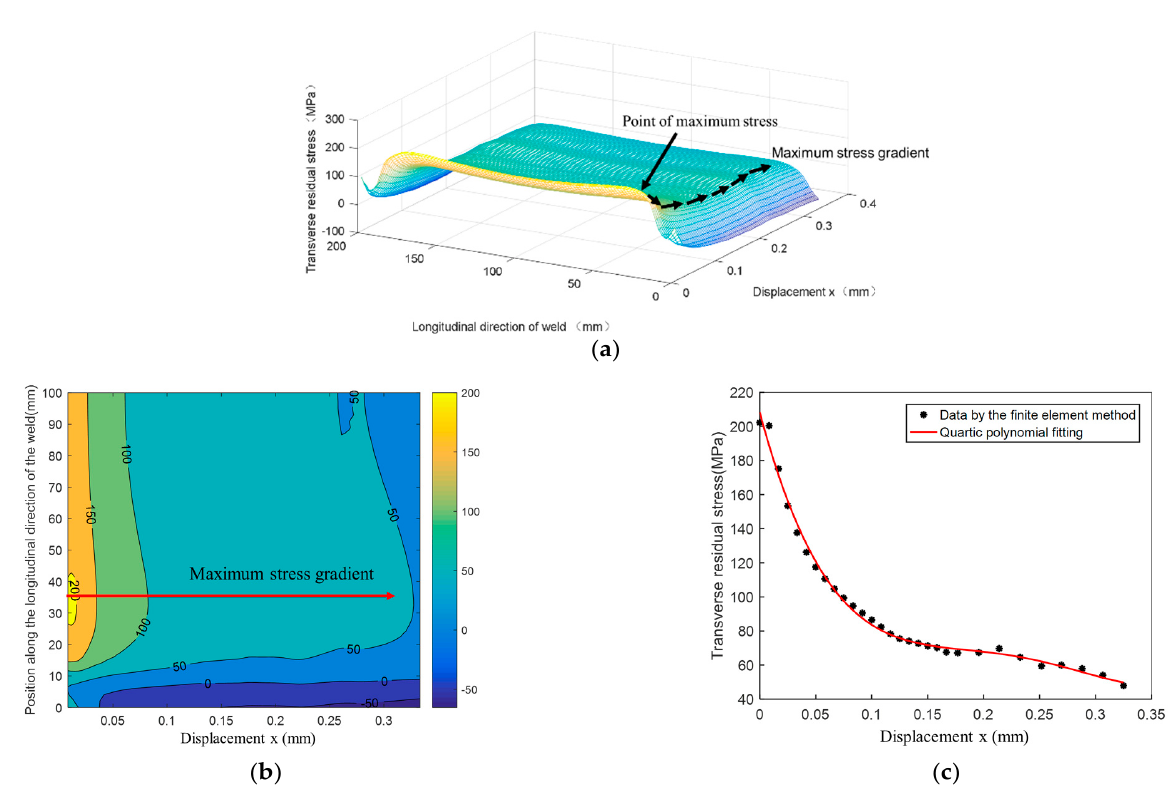
Figure 14. Results of welding residual stress distribution and fitting of maximum residual stress gradient. ( a ) Three-dimensional graph of residual stress on crack propagation surface; ( b ) Contour map of residual stress on crack propagation surface; ( c ) Fitting of transverse residual stress and displacement x .